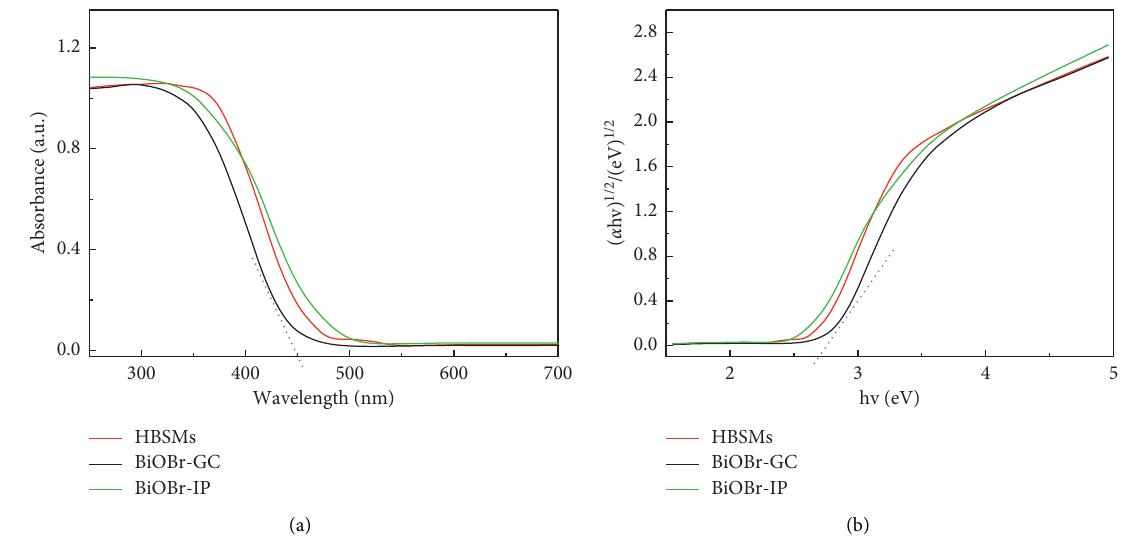
Figure 7: (a) UV-vis absorption spectra and (b) the plot of (Ahv) 1/2 versus photon energy (hv) of the resultant BiOBr samples as indicated.